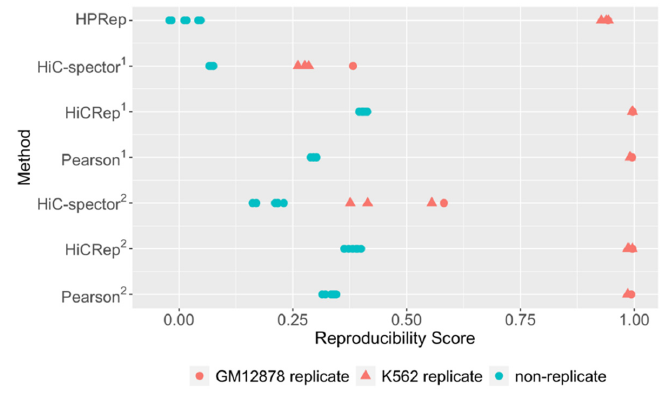
Figure 4. Comparison of methods in HiChIP datasets from human blood cell lines. HPRep compared to Hi-C specific methods HiC-Spector and HiCRep as well as Pearson correlation. (1) All methods using bin pairs in the AND and XOR sets. (2) Methods other than HPRep using all bin pairs in the AND, XOR, and NOT sets. HiChIP dataset consisted of two GM12878 replicates and three K562 replicates.